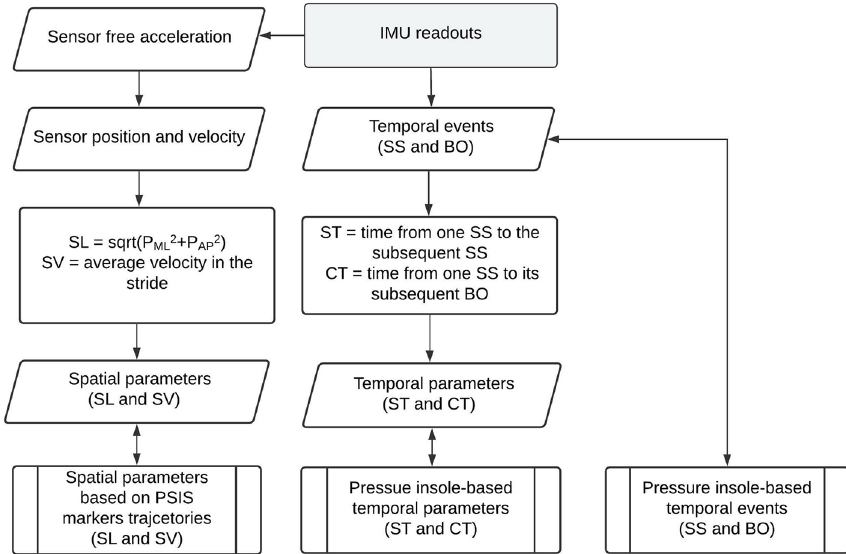
Figure 3. Flowchart of the measurement of temporal and spatial parameters of ice skating using IMU readouts and comparing it with the ones obtained by stationary in-lab reference systems. Here, sqrt stands for square root, and p ML and p AP respectively are the travel distance in the mediolateral and anteroposterior directions in each stride.